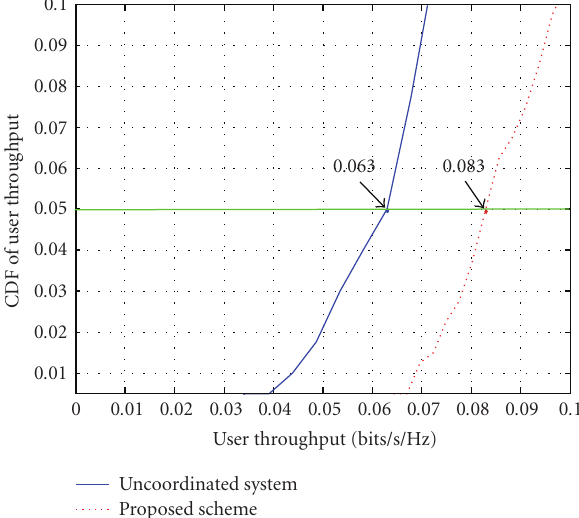
and cell-edge user throughput based on SINR thd = 0 dB are shown in Figures 4 and 5,